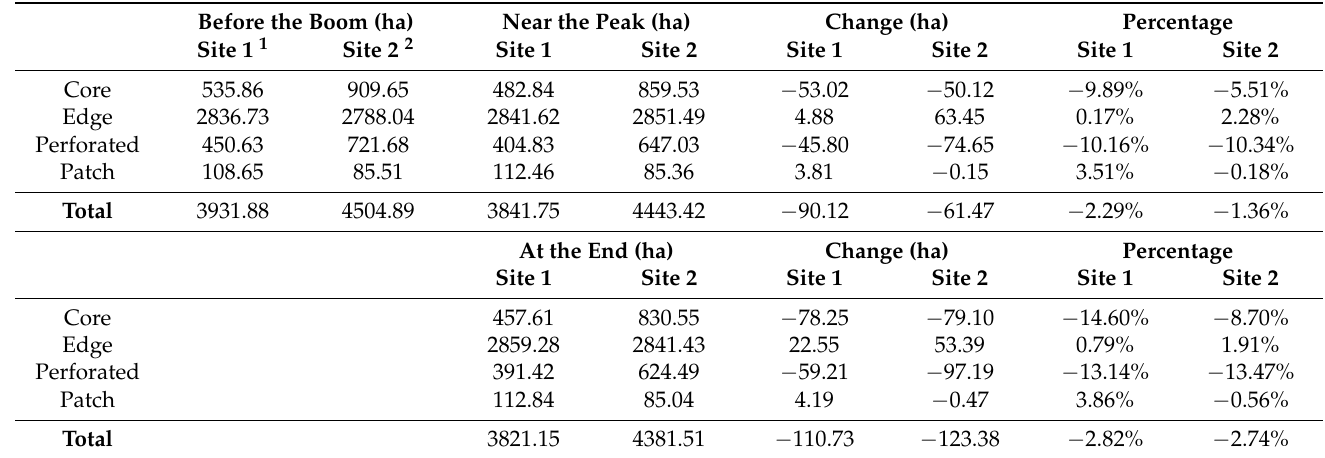
Table 6. Forest structural changes at two representative test